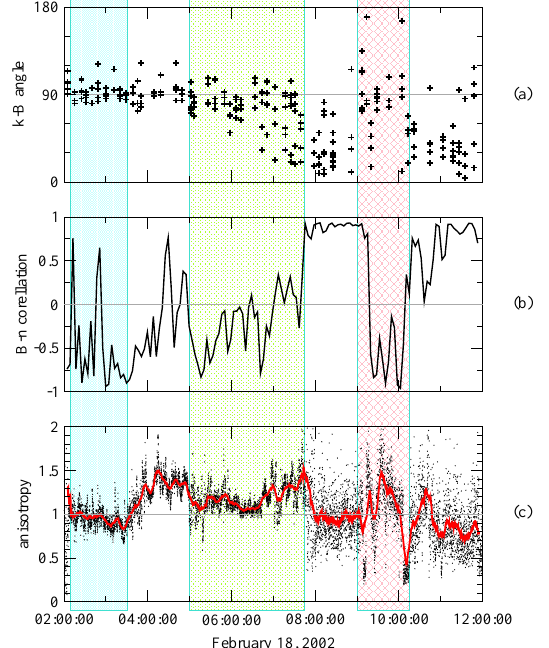
Fig. 8. The propagation angle with respect to the background mag- netic field (a) , the correlation between the magnetic field magnitude and the plasma density (b) , and the proton temperature anisotropy (c) . The anisotropy plot shows both the 4-s resolution anisotropy (scattered black dots) and the 10-min running average (red